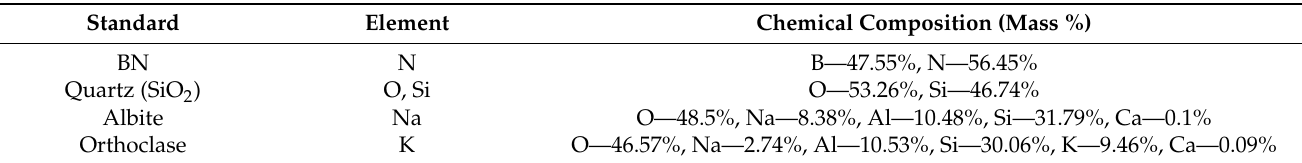
Table 2. Standards (comparison samples of the chemical composition) used in the elemental analysis of the coating. Standard Element Chemical Composition (Mass %) BN Quartz (SiO 2